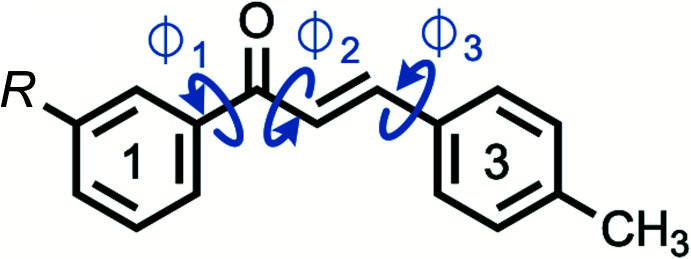
Three key dihedrals describing the chalcone planarity for 3′-cyano-4-methyl­chalcone (m′CNpCH3) and 3′-bromo-4-methyl­chalcone (m′BrpCH3); the 1-Ring and 3-Ring are labelled, where R = CN, Br.